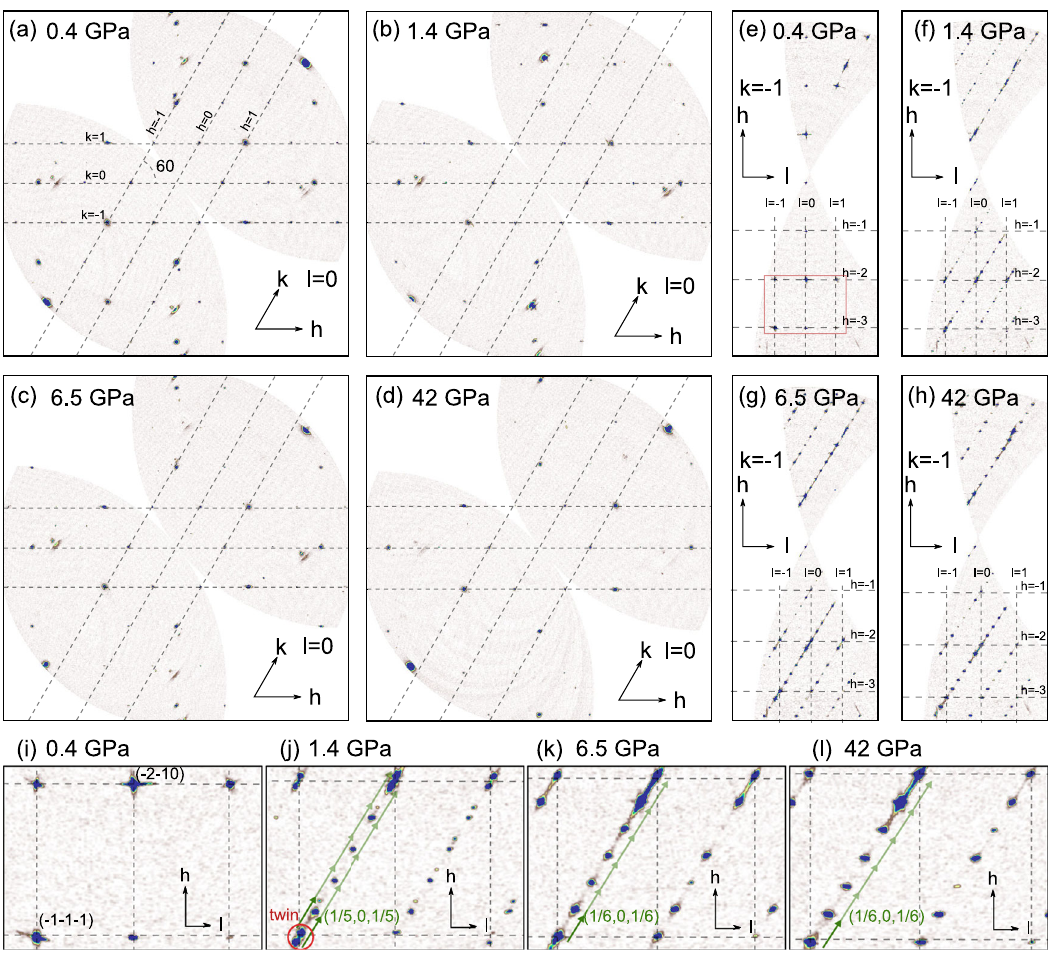
Fig. 2 Reconstructed reciprocal space maps as a function of pressure. a – d hk 0-planes for the trigonal host phase at 300K and 0.4 GPa ( a ), the triclinic 1/5- phase at 300 K and 1.4 GPa ( b ), the monoclinic 1/6-phase at 350K and 6.5GPa ( c ), and at 42GPa ( d ). e – h Same as ( a – d ) but for the h (cid:1) 1 l -plane. i – l magni fi cations of the images shown in ( e – h ). The red rectangle in ( b ) indicates the region which is magni fi ed in ( i – l ). Reciprocal lattice vectors and Miller indices h , k , and l refer to the hexagonal cell and an approximately hexagonal cell for the 1/5- and 1/6-phase. Green arrows in ( j – l ) depict the q